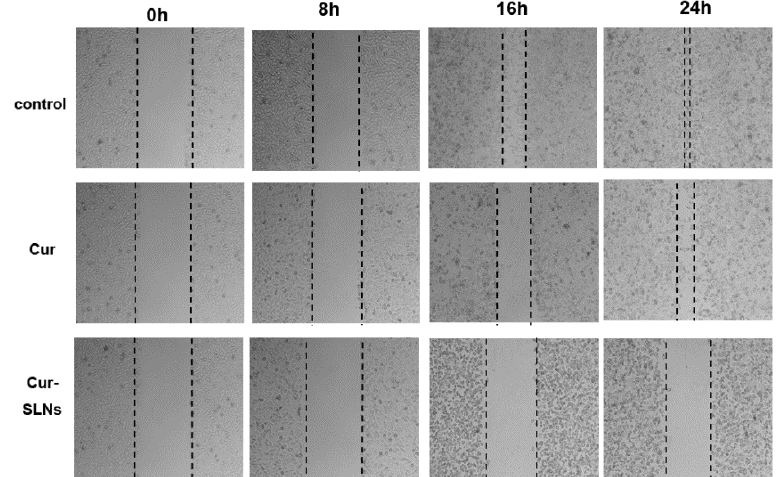
Figure 6. Wound-healing assays were performed to assess cell migration. SKBR3 cells were seeded in migration chambers and treated with curcumin and Cur-SLNs at 20 μM. Images of the migration area were photographed 0 h, 8 h, 16 h, and 24 h. Representative images taken from duplicated experiments.